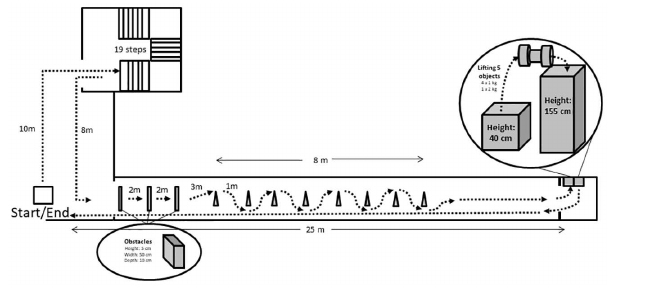
Fig 2. Schematic illustration of the